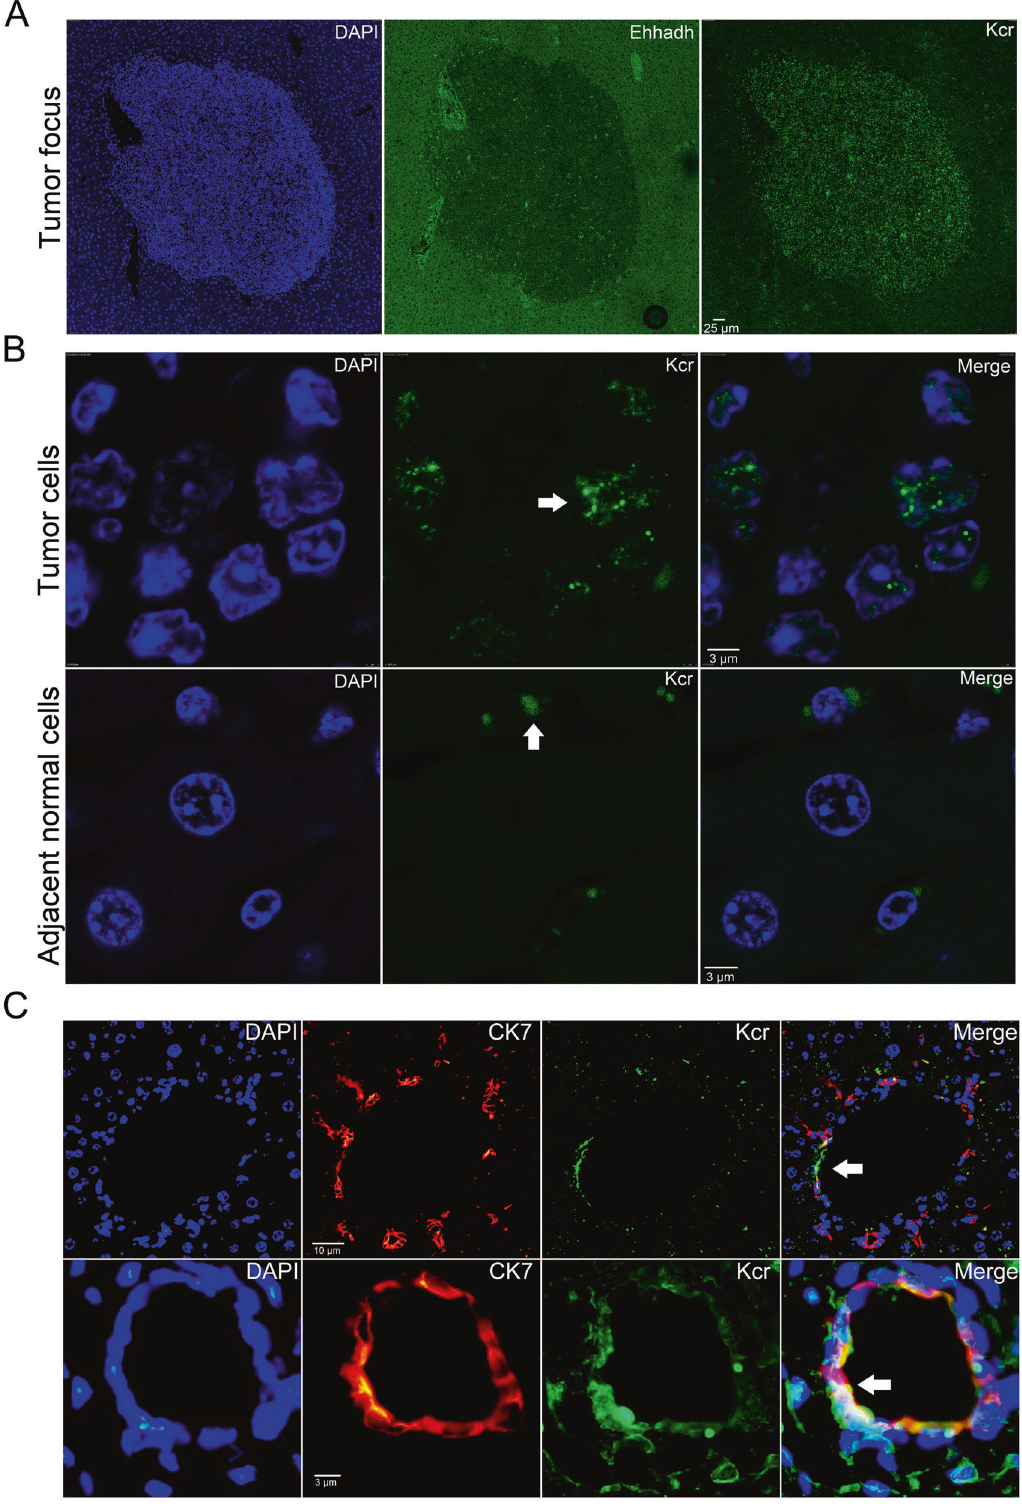
Fig. 3 Kcr levels are associated with HCC progression in Acox2 − / − mice. A Fluorescent immunohistochemistry using DAPI, anti-Ehhadh and pan anti-Kcr were performed on three slides of a single tumor focus. Scale bar, 25 μ m. B Immunohistochemical staining showed Kcr signals were concentrated in the nucleus of tumor cells (upper panel) but mainly located in the cytoplasm of adjacent normal liver cells (bottom panel) in Acox2 − / − mice, Scale bar, 3 μ m. C Kcr levels were increased in the regions of bile duct proliferation in Acox2 − / − mice by double immunostaining with Kcr and a ductal marker CK7. Co-localization of Kcr signal with CK7 was observed and indicated by white arrow. Representative images were displayed. Scale bar, 10 μ m (upper) and 3 μ m (bottom).